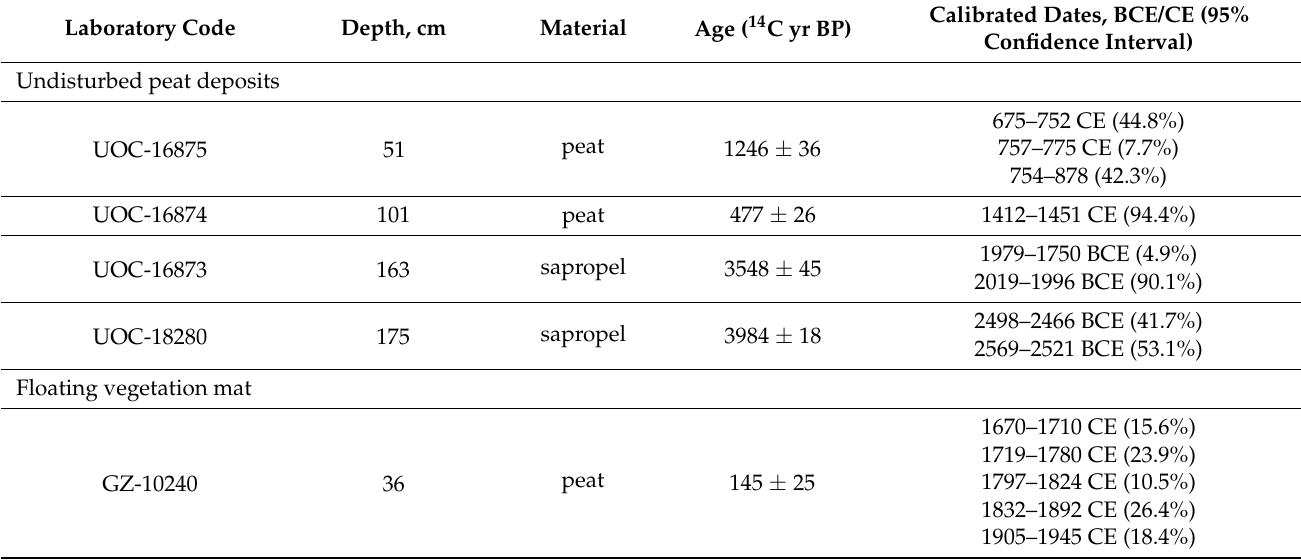
Table 1. Radiocarbon dates of the undisturbed peat deposits and the floating vegetation mat from the Gorenki mire. BP—before